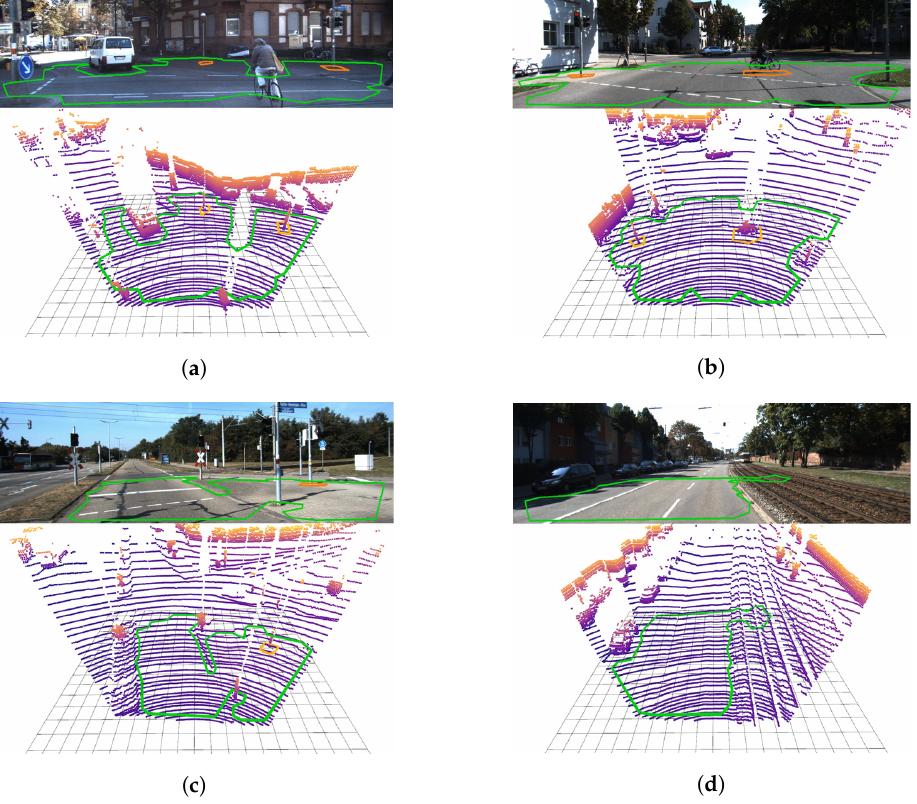
Figure 17. Polygon extraction from KITTI unorganized 3D point cloud data acquired on a moving vehicle [63]. Four scenes ( a – d ) are shown, each with two subimages. The top subimage shows polygons projected into the color image while the bottom image shows 3D point cloud and surface polygon(s) from a bird’s eye view. Obstacles on the ground such as the light and signal in ( a ) are extracted as (orange) holes.